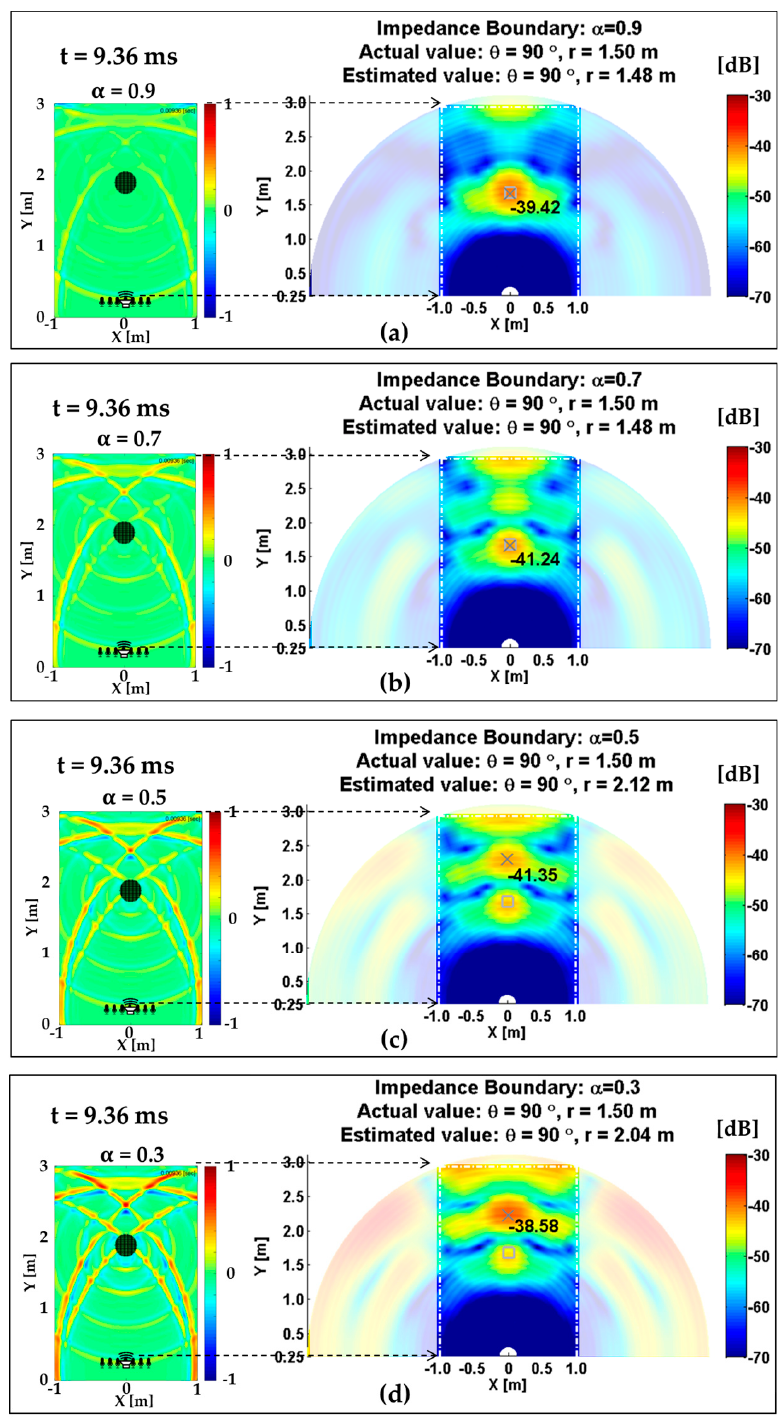
Figure 9. Simulation results of the active localization method according to the change in absorption coefficient α : ( a ) α = 0.9; ( b ) α = 0.7; ( c ) α = 0.5; ( d ) α = 0.3. The square marker is the actual position and the cross marker is the estimated position.